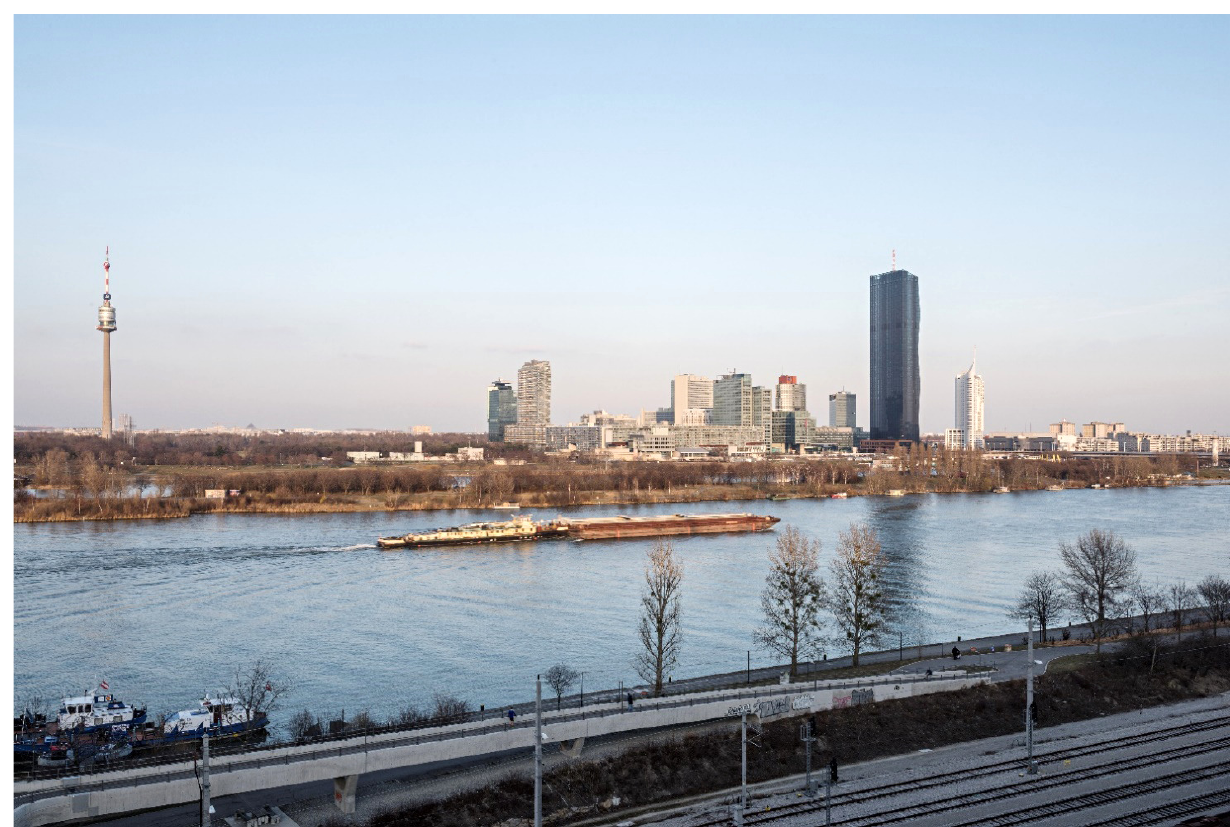
Figure 5. Donau City, Vienna. Source: Photo by © Hertha